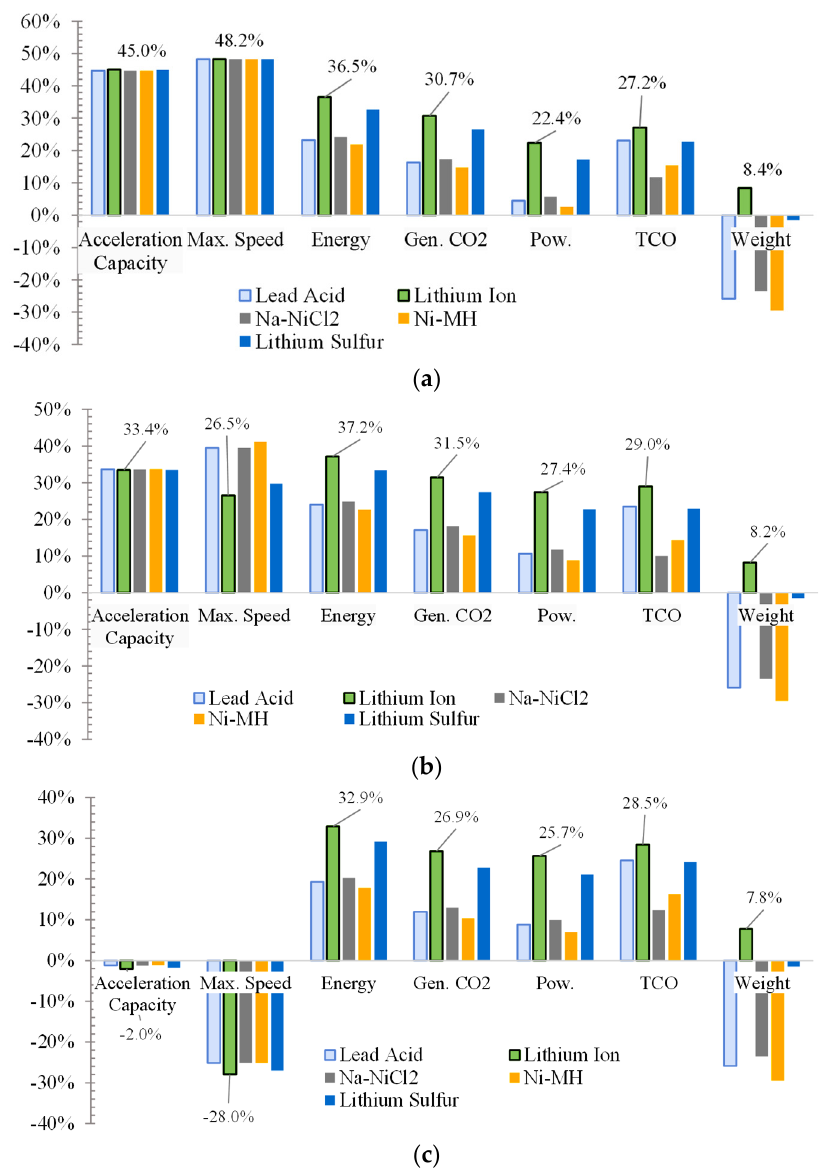
Figure 10. The relative difference between electrical and original configurations for ( a ) low SFC, ( b ) typical SFC, and ( c ) high SFC scenarios. Note: Values obtained with lithium-ion (Li-Ion) batteries are highlighted.